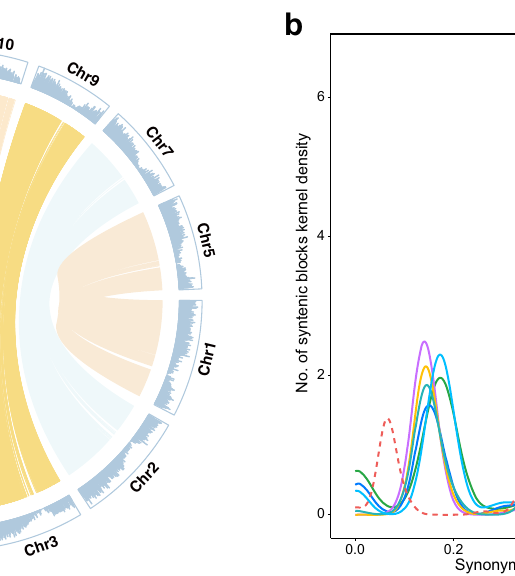
homoeologous chromosome pairs derived from the most recent shared WGD event. b The K s distribution for the median K s of each collinear block of seven Juglandaceae species. Source data are provided as a Source Data fi